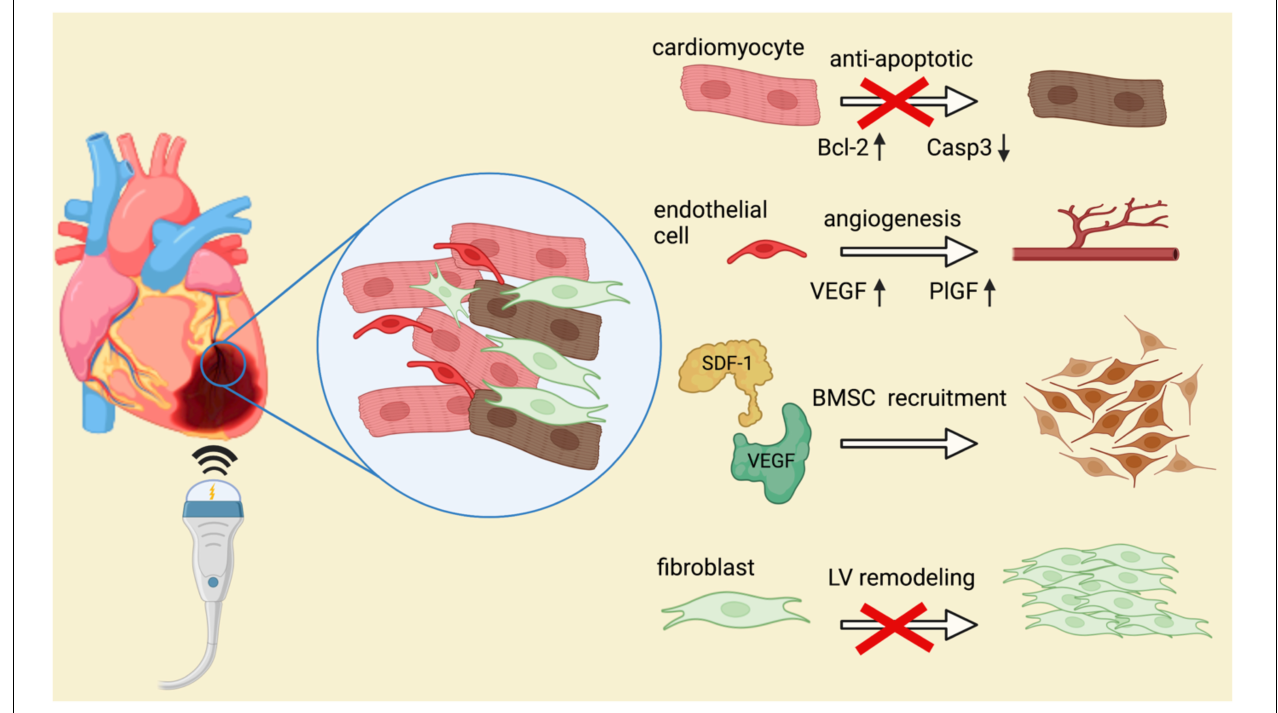
FIGURE 1 | Molecular mechanisms of shockwave therapy in ischemic heart disease. Several mechanisms of positive impacts mediated by SWT on the course of ischemic heart disease have been described. By regulation of anti-apoptotic proteins, cardiomyocyte survival is enhanced and hence, cardiac damage limited. Angiogenesis upon shockwave therapy is mediated via release of endothelial growth factors VEGF and PlGF. SDF-1 acts as a chemoattractant of angiogenic bone marrow derived stem cells. Migration of these progenitor cells is crucial for induction of vasculogenesis and revascularization of ischemic tissue. Moreover, shockwave therapy was shown to reduce the number of fibrocytes within chronic ischemic myocardium, thereby promoting reverse LV